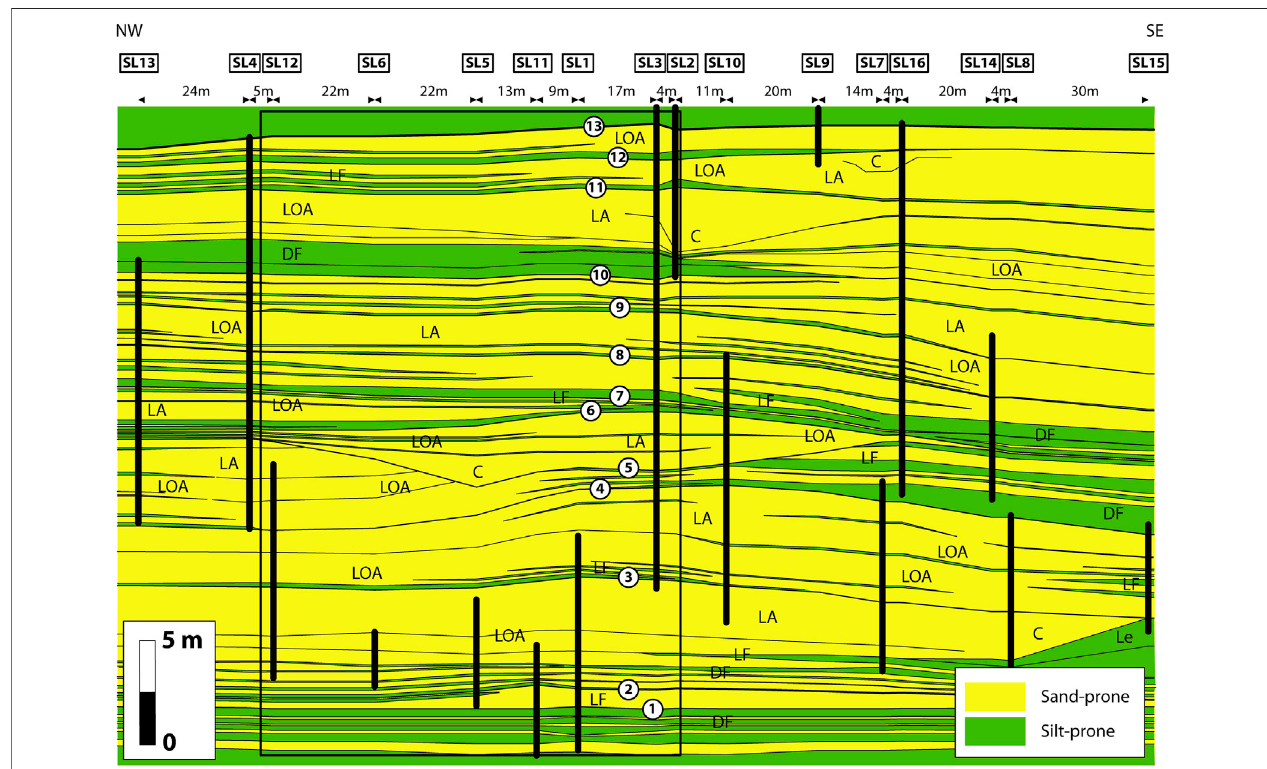
FIGURE 10 | Correlation panel of the Saetta area illustrating stacked lobes. The black rectangle corresponds to Figure 9 with horizontal extension from sedimentologicalsectionSL12toSL2.Thickverticalblacklinescorrespondtothesedimentologicalsections.(C)Channel,(Le)Levee,(LA)Lobeaxis,(LOA)Lobeoff-axis, (LF) Lobe fringe, (DF) Distal lobe fringe.